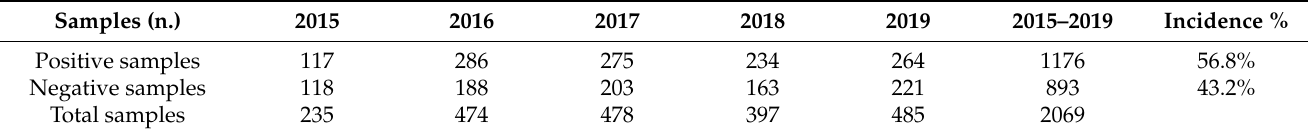
Table 1. Positive, negative and total vaginal swabs analyzed during the five years of study, for each year and in total. The last column shows the relative percentage of incidence based on the five years summarized. Samples